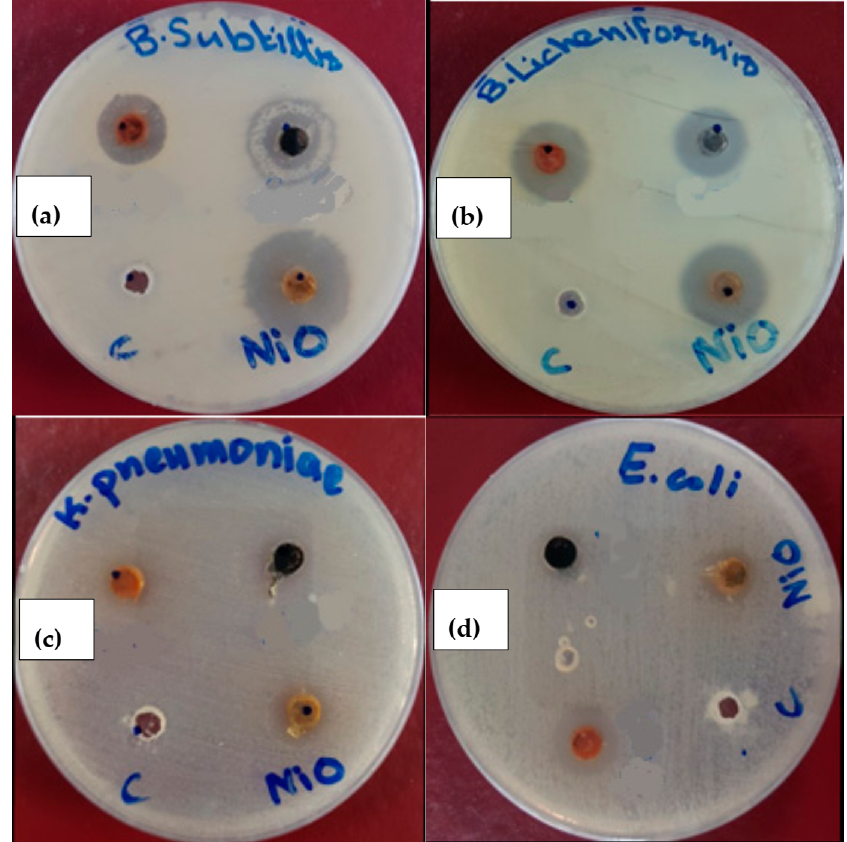
Figure 10. Experimental photographs of antibacterial activity of biogenic NiO NPs against Gram- positive ( B. subtilis ( a ) and B. licheniformis ( b )) and Gram-negative bacteria ( K. pneumoniae ( c ) and E. coli ( d )). Table 4. Antibacterial activity of NiO NPs against Gram-positive and Gram-negative bacteria at different concentrations; the activity is shown in millimeter (mm), no replicated experiment was performed. The correlation between utilized dose and obtained data was studied by applying t test. Volume of NiO Suspension Correlation between Utilized C = Solvent Microorganism Dose and Obtained Data ( p = 0.05) DMSO25 µ L 50 µ L 75 µ